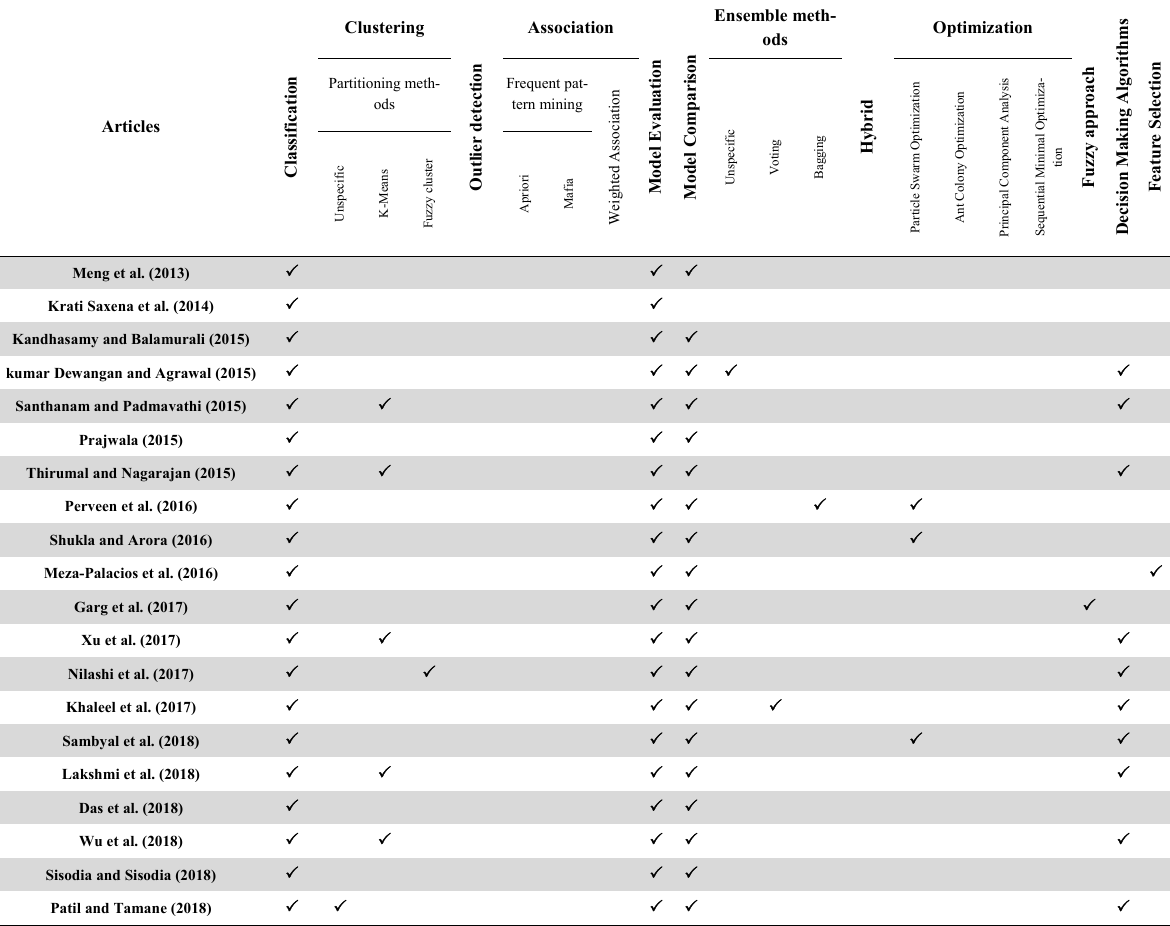
The overall review of the data mining techniques in diabetes diagnosis